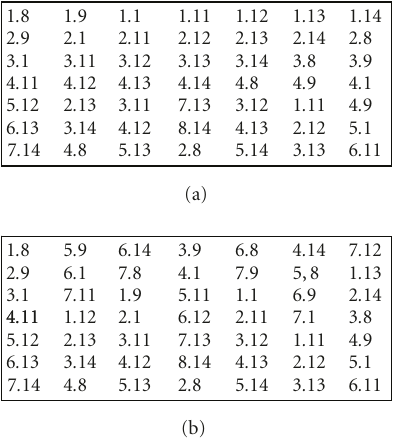
Figure 5: Girth-eight row connections using (a) sequential search (b) random search.